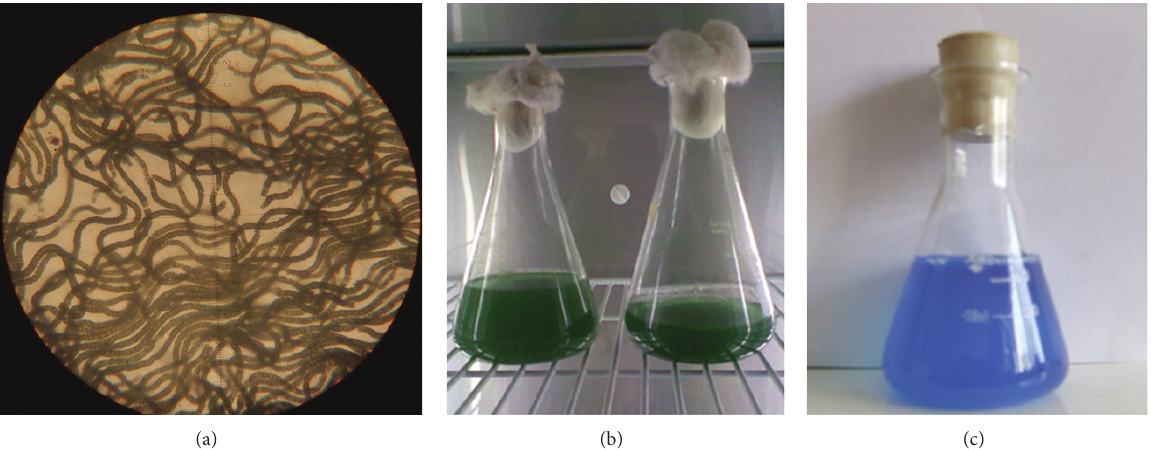
Figure 1: The sample of live spirulina under microscope (a) and in incubator (b) and the phycobiliprotein extracted (c).